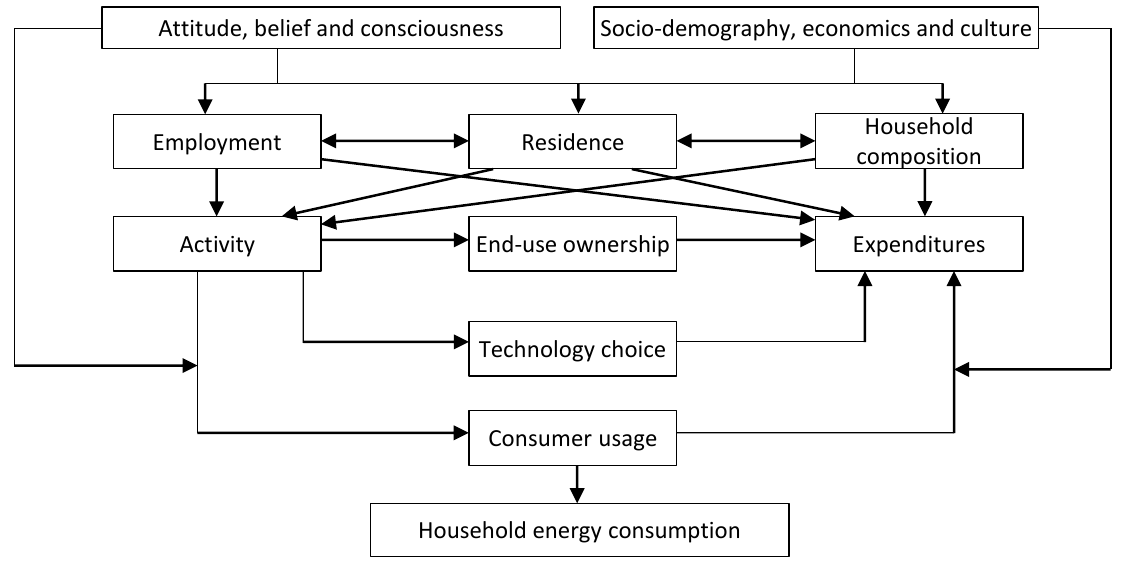
Figure 2. The relation between life choices and energy consumption